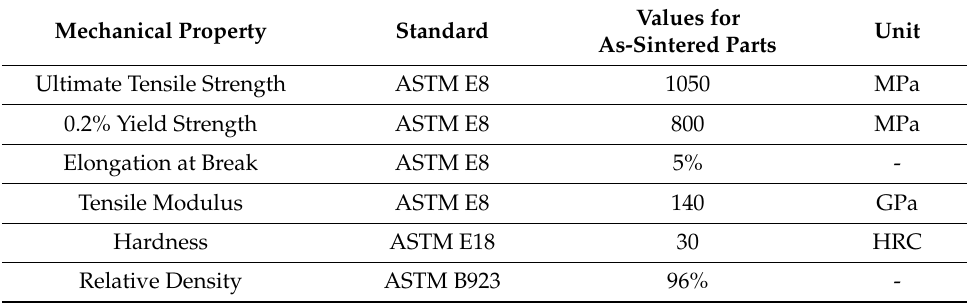
Table 3. Markforged 17-4 PH stainless steel mechanical properties